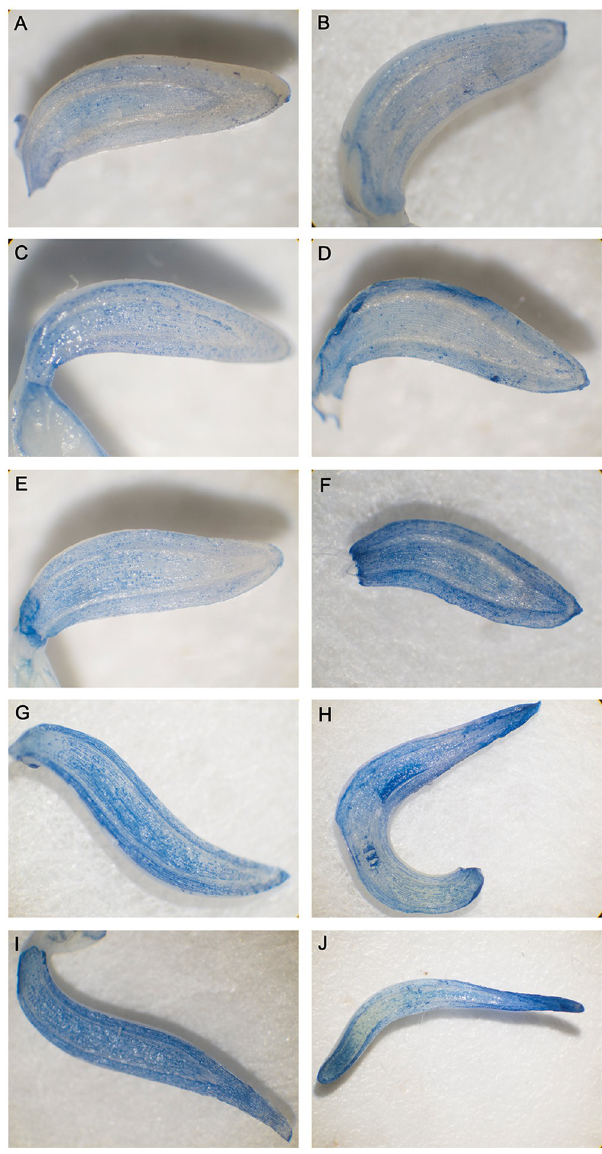
Fig 1. Evans blue staining of mung bean hypocotyls in different preimbibition and dehydration states. A, C, E, G and I represent the longitudinal section of the hypocotyl at 0, 3, 6, 18 and 24 h of preimbibition, respectively. B, D, F, H and J represent the longitudinal section of the hypocotyl at 0, 3, 6, 18 and 24 h of preimbibition after 24 h of dehydration, respectively.